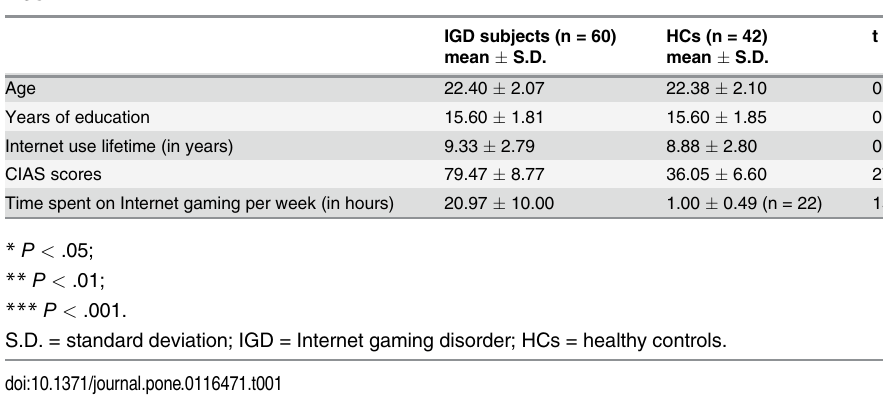
Table 1. Demographic, Internet use lifetime, the CIAS scores and time spent on IGD subjects and HCs.